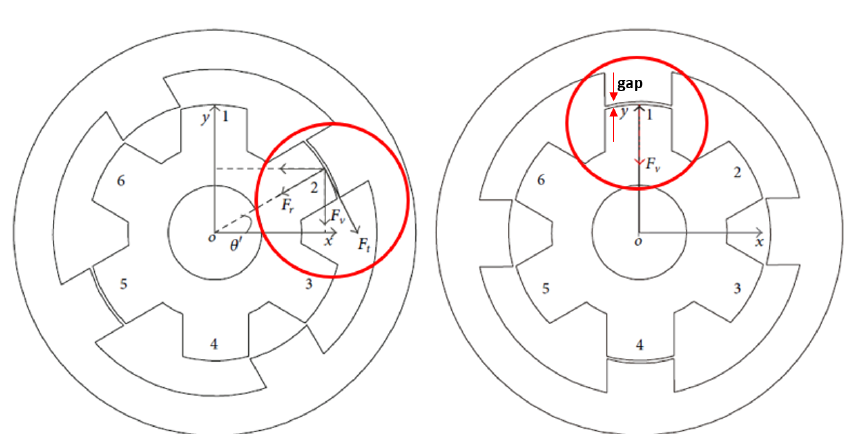
Figure 4. Residual vertical force.